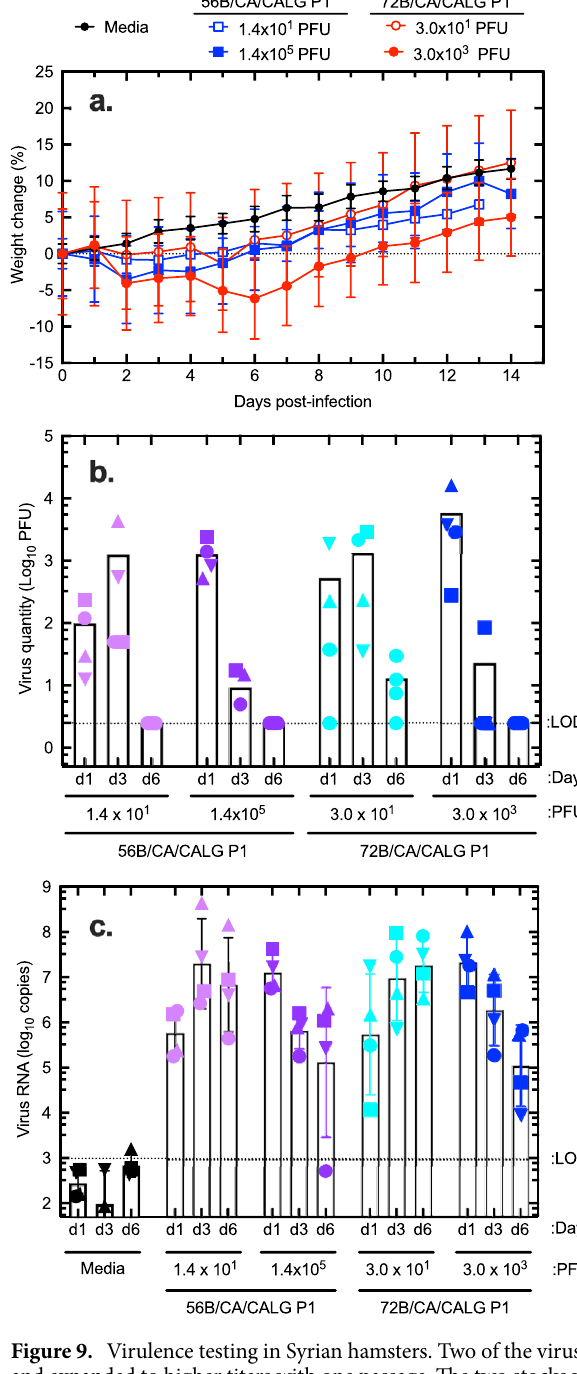
Figure 9. Virulence testing in Syrian hamsters. Two of the virus specimens (56B and 72B) were plaque purified and expanded to higher titers with one passage. The two stocks were then used to inoculate four groups of hamsters (4 per group) with the indicated doses of virus. Four control animals were also inoculated by the same intranasal route, with an equal volume (100 µL total) of serum-free media. ( a ) Shows the weight change relative to the starting weight for the animals in each of the five groups. Error bars represent standard error of the mean. A nasal swab was collected from each animal on days 1, 3 and 6, post-inoculation, and assayed for virus by plaque assay and virus RNA by qPCR ( b and c ). Both virus specimens produced weight loss and high titers of intranasal virus were detected at days 1 and 3 post-infection. Characteristically the lower doses (14 PFU for 56B and 30 PFU for 72B) yielded the most virus on day 3 post-infection, whereas the higher doses induced the highest levels of infection immediately after challenge, on day 1. The RNA is more persistent than virus, and it could still be detected 6 days post-infection in all of the infected animals, whereas no virus could be detected at this date. The animals were euthanized at day 14. The dashed lines show the limits of virus and RNA detection (LOD) in nasal swabs. Figure prepared using Prism v9.3 (https:// www. graph pad.